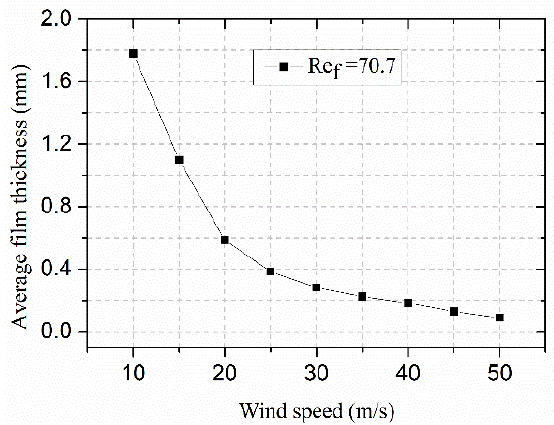
Figure 6. The variation in the wind velocity and the average water film thickness.